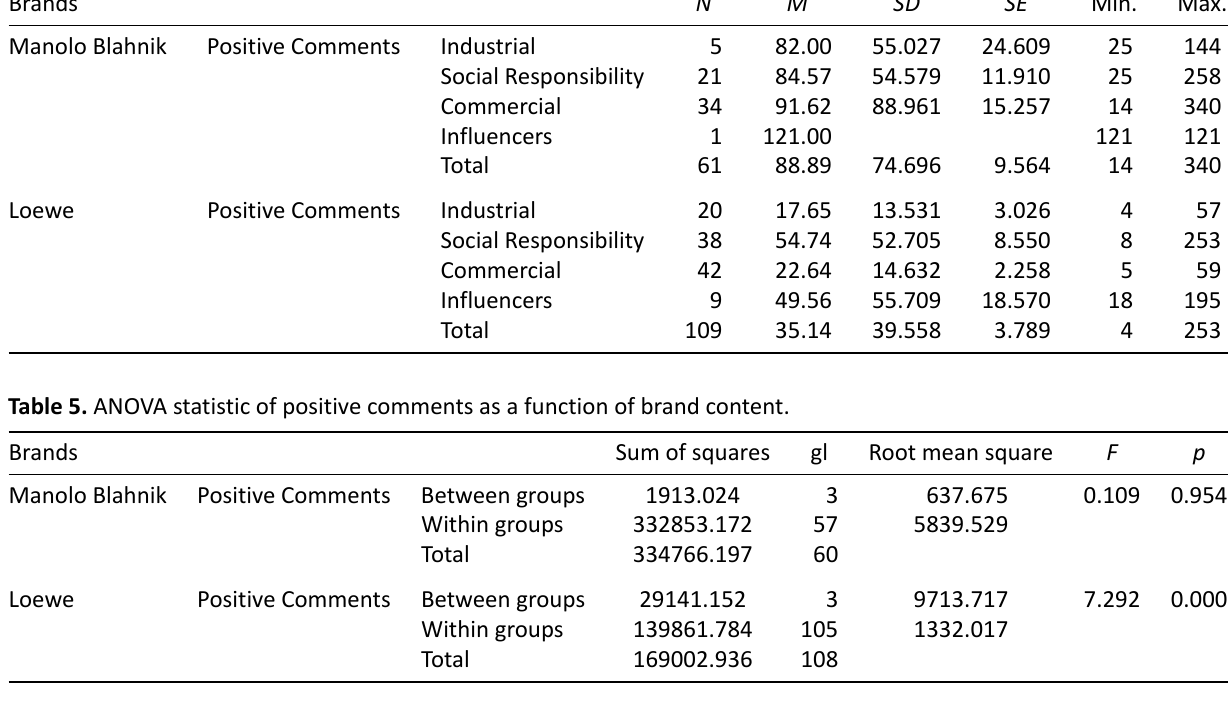
Table 4. Descriptive statistics of the positive comments generated according to brand content. Brands